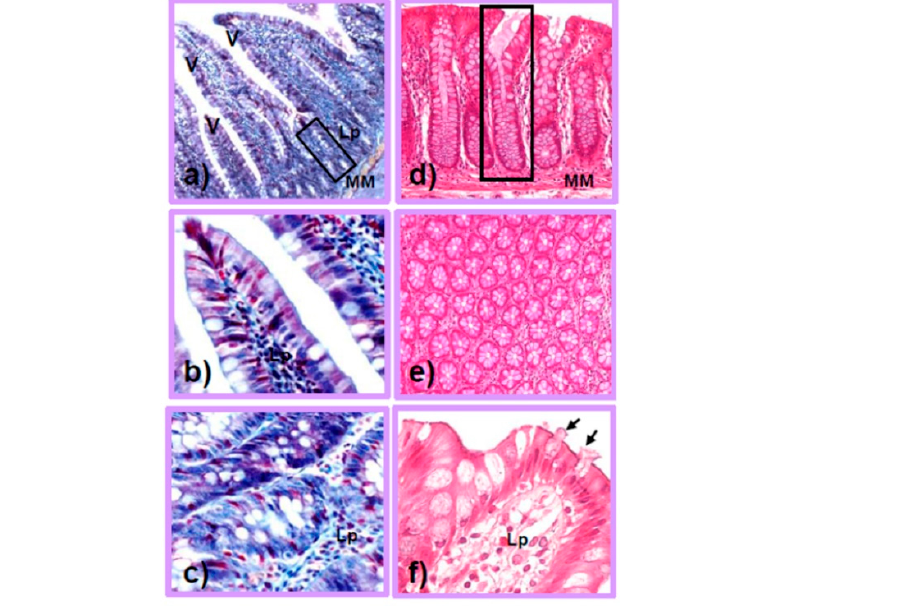
Figure 1. Representative micrographs of small intestine (jejunum) ( a , c , e ) and large intestine (colon) ( b , d , f ). ( a ) Jejunum: tunica mucosa showing the villi (V) projecting into the lumen and the intestinal Lieberkühn crypts extending in the lamina propria (Lp) (some of those in the boxed area are enlarged in panel c ). The muscularis mucosae (MM) is also observed. ( b ) Villus lined by a simple columnar epithelium, including the enterocytes (stained in blue) and mucus-secreting goblet cells, with pale cytoplasm. The core of the villus is formed by the lamina propria (Lp). ( c ) Jejunum: at higher magnification, the crypts, located in the lamina propria (Lp) of the mucosa, contain abundant goblet cells. ( d ) Colon: tunica mucosa, showing the absence of villi and presence of abundant simple tubular glands, containing mostly goblet cells. ( e ) Cross-section of the simple tubular glands located in the connective tissue of the lamina propria in the mucosa of the colon. ( f ) Tunica mucosa of the colon, showing the simple columnar lining of the epithelium and the frequent goblet cells intercalated between the enterocytes—some of them are releasing their secretory products (arrows). They lie on the lamina propria (Lp). ( a – c ) Azan–Mallory staining; ( d , e ) H&E staining. Original magnification: 10 × ( a ), 20 × ( d , e ), 40 × ( b , c , f